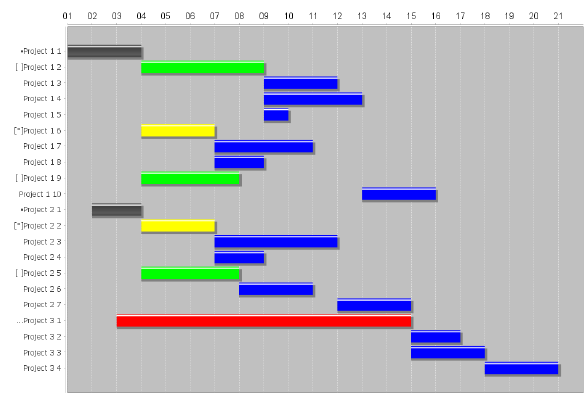
Figure 1: Sample of a company order execution schedule ( RRMSCC screenshot).